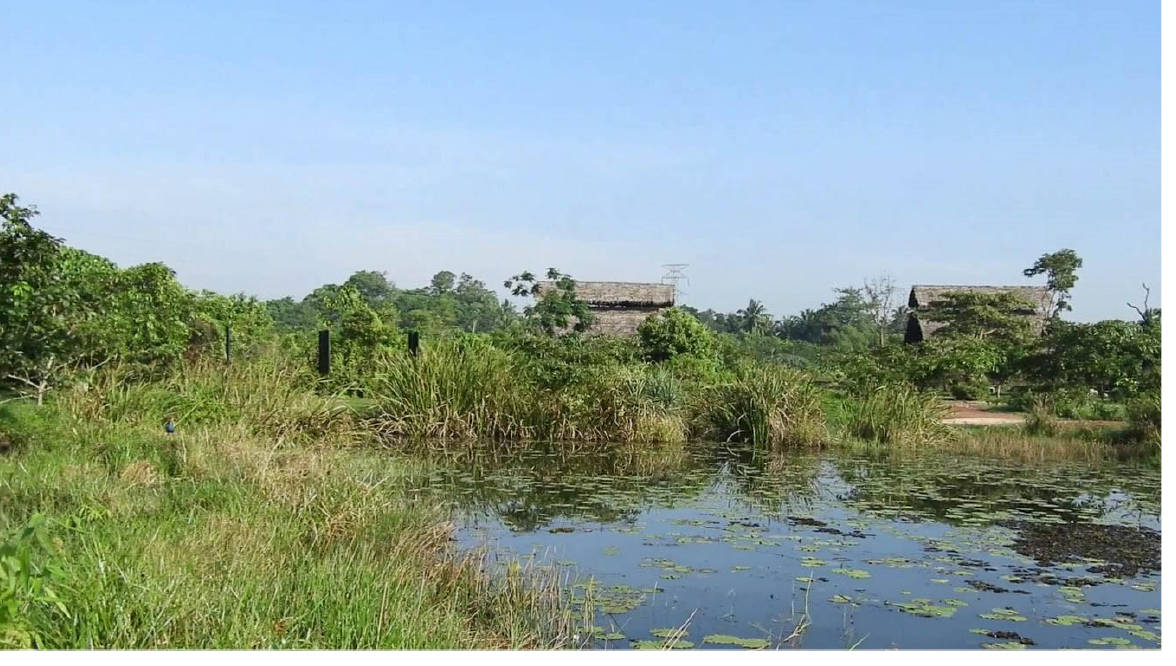
Figure 11. Diyasaru water park—a newly renovated urban wetland with multiple functions including recreation and research opportunities etc. (Field survey, 2021).